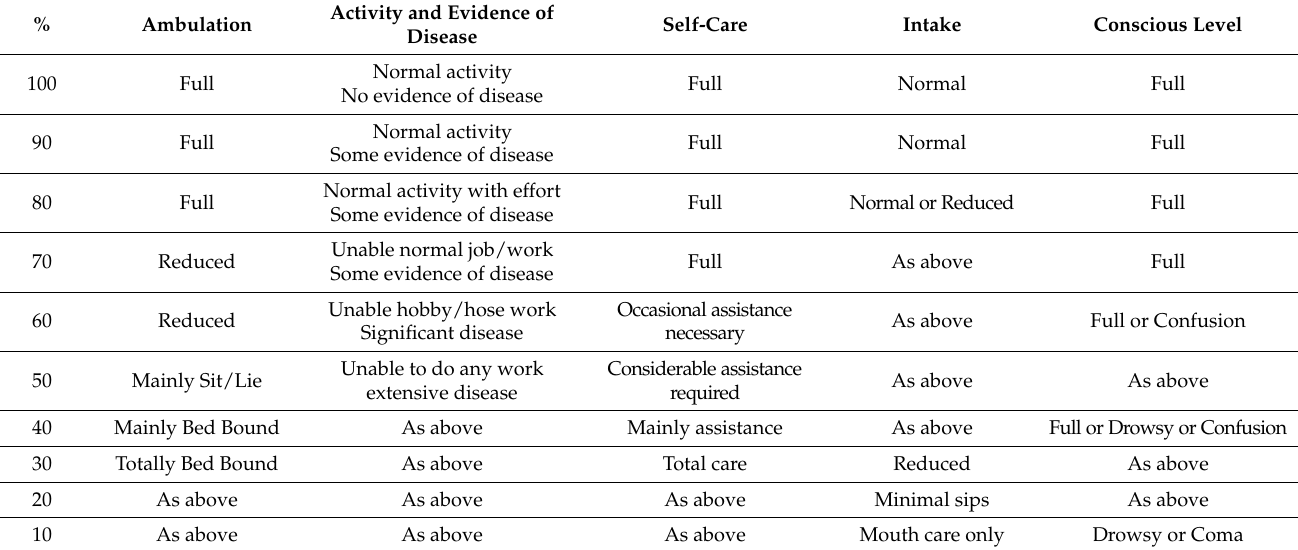
Table 4. Palliative Performance Scale